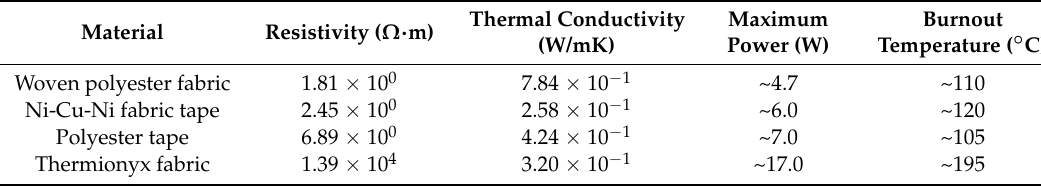
Table 8. Conductive Fabric Properties.